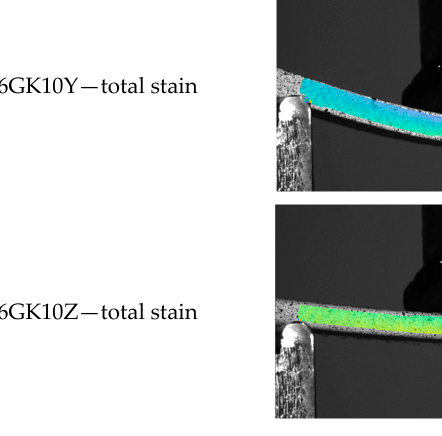
Figure 5. Strain levels registered via the DIC method.